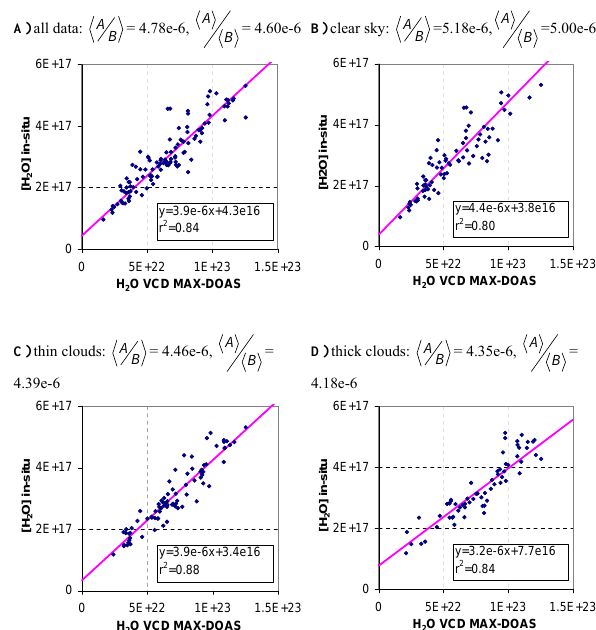
i and h A i h B i B